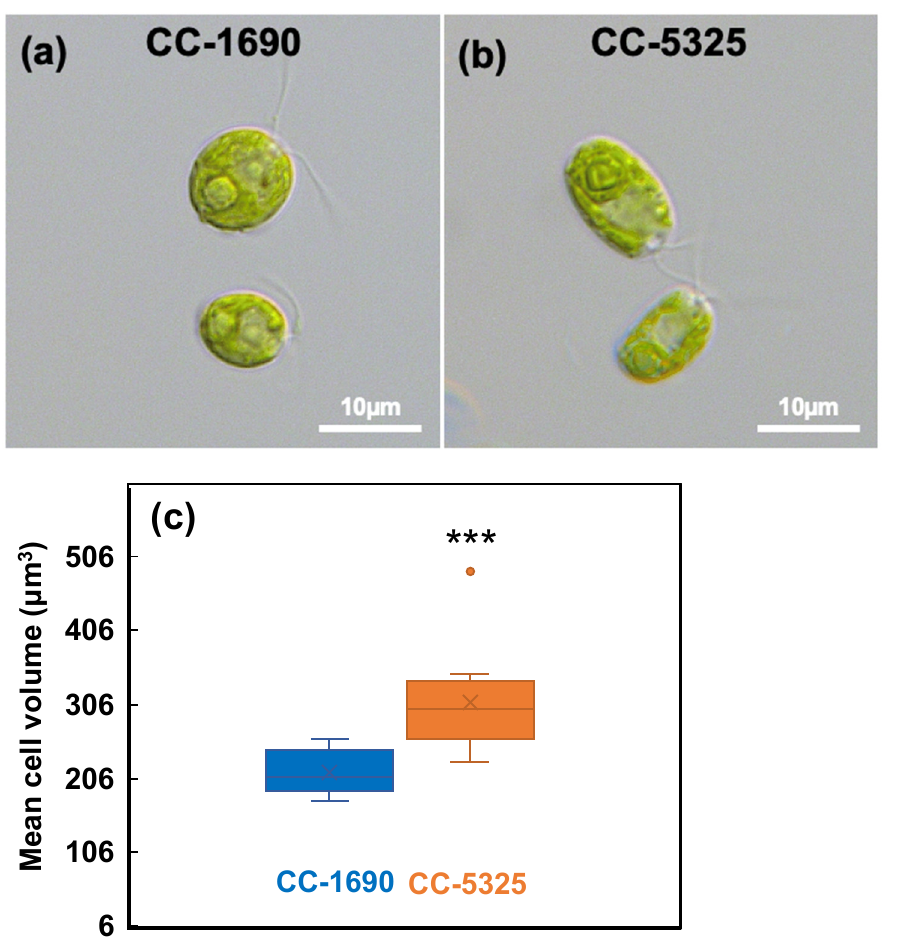
Figure 1. CC-5325 had larger cell volume than CC-1690. ( a , b ) Light microscopic images of Chlamydomonas cells. ( c ) Boxplot of mean cell volume determined using a Coulter Counter. N = 12 biological replicates for each strain. Statistical analyses were performed using a two-tailed t -test assuming unequal variance by comparing with CC-1690. ***, p < 0.001.